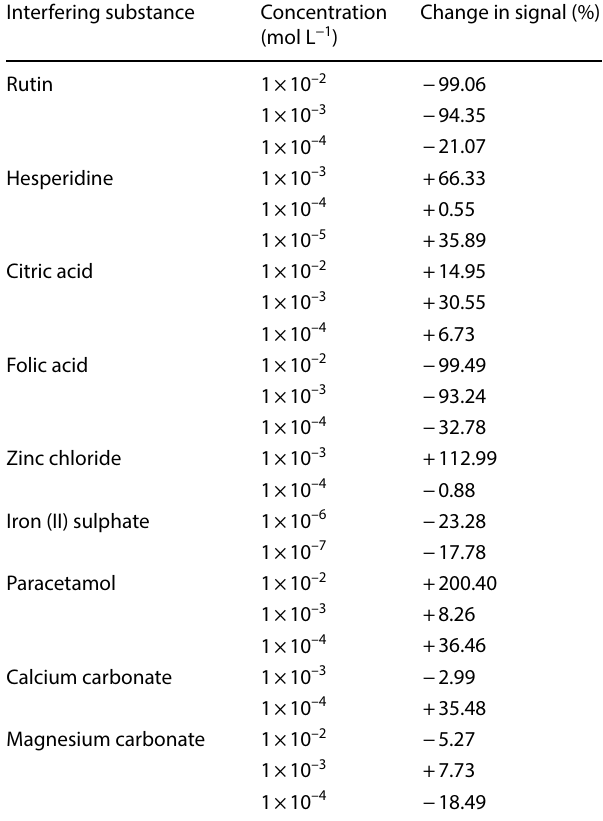
Table 6 Influence of interferences on the relative intensity of fluo- rescence for the determination of ascorbic acid. Interfering